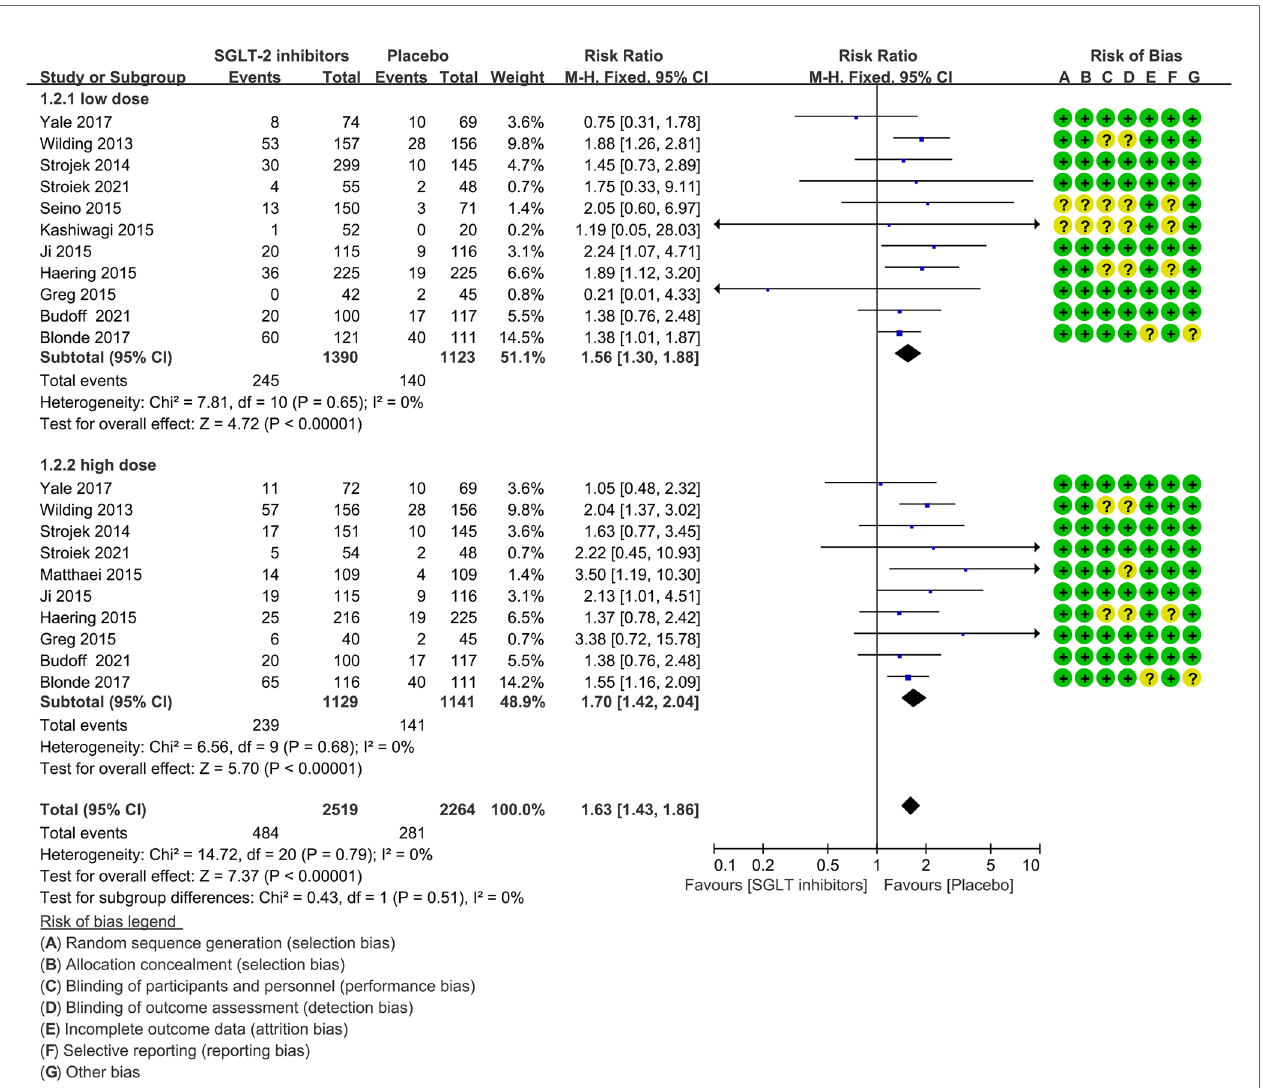
FIGURE 6 | Risk of hypoglycemia in subgroups. Forest plot showing risk of hypoglycemia in patients treated with higher or lower SGLT-2 inhibitors plus sulfonylureas compared with placebo plus